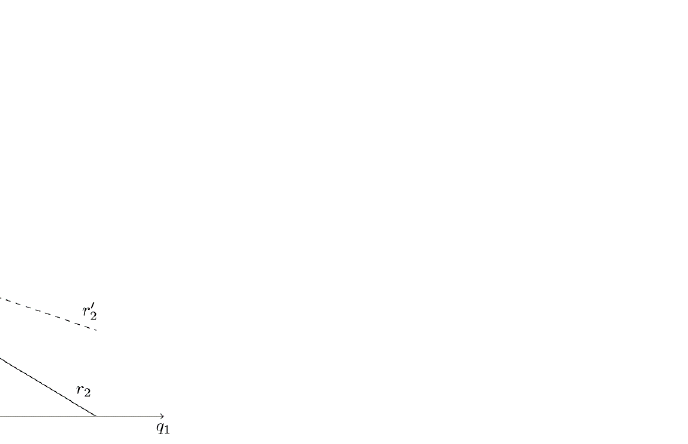
Figure 4. The Subgame-Perfect Nash Equilibrium ( SPNE ) When Owners Hire CEOs Who Underestimate Product Substitutability.